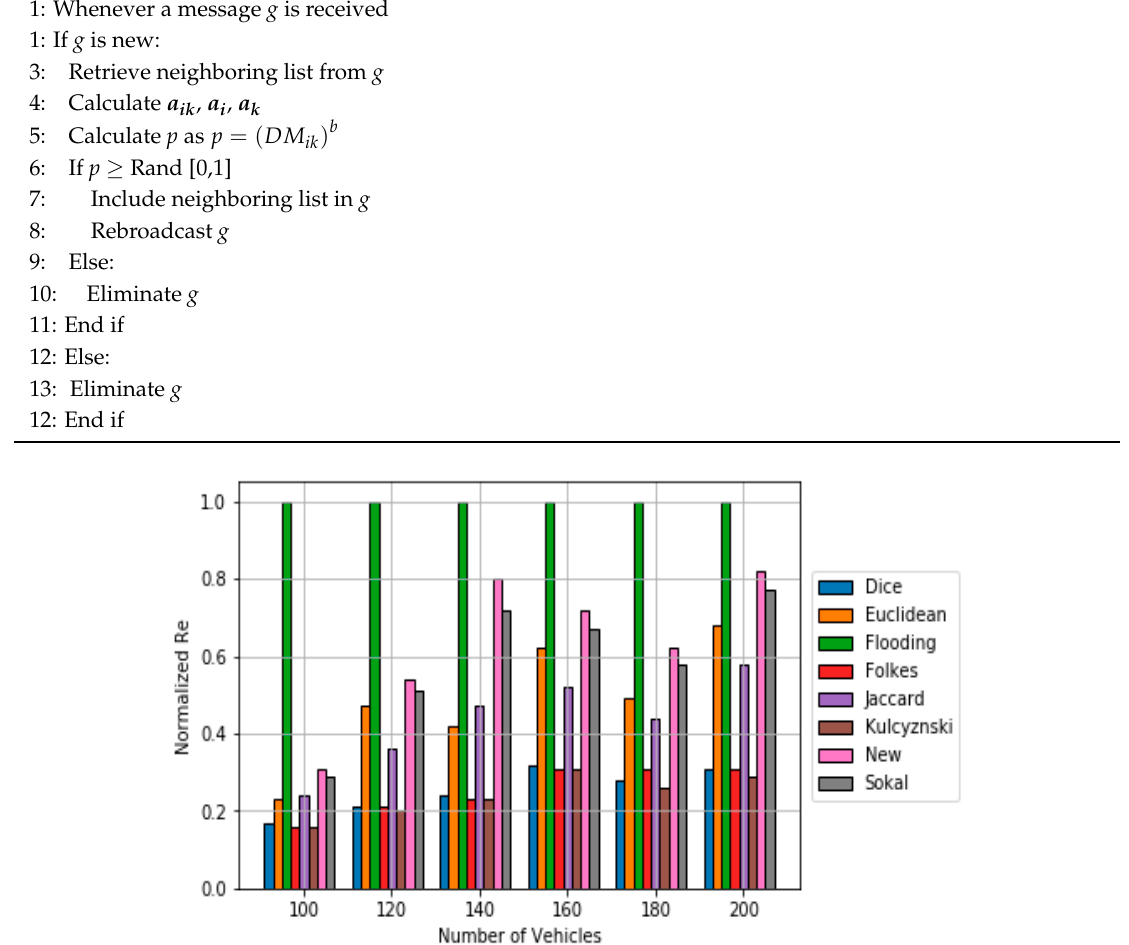
Algorithm 3. Polynomial algorithm based on dissimilarity metric.